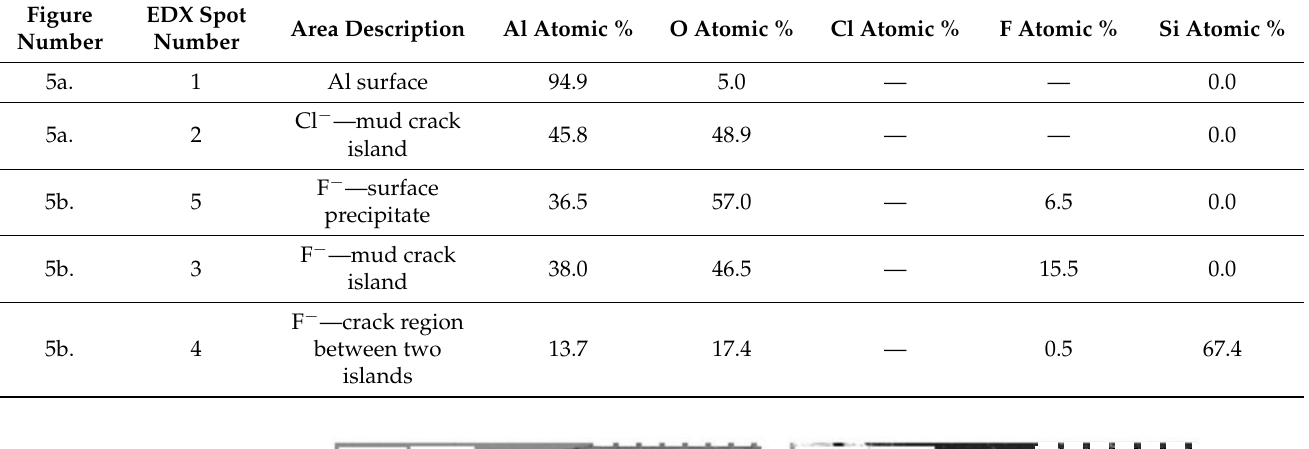
Figure 3. SEM analysis of corroded Al surface. ( a ) Al surface after 24 h immersion in 5 ppm Cl − at pH 5. Inset (white dotted line): Close-in view of mud crack in Cl − -induced corrosion. ( b ) Al surface after 24 h immersion in 5 ppm F − at pH 5 — close-in view of mud cracks formed in F − -induced corro- sion. Inset (white dotted line): Close-in view of the pitting region. Note: EDX analyzed the num- bered cycle areas; results are listed in Table 1.